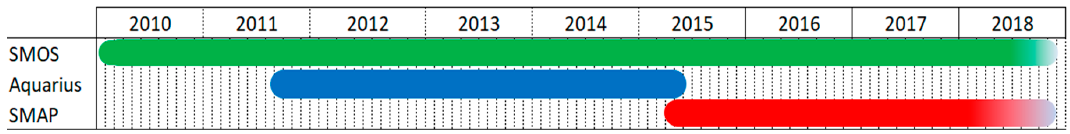
Figure 1; SMOS and Aquarius overlap for almost four years (the whole Aquarius mission lifetime); SMAP overlaps Aquarius during the last two months of Aquarius life; SMOS and SMAP have been overlapping since April 2015.